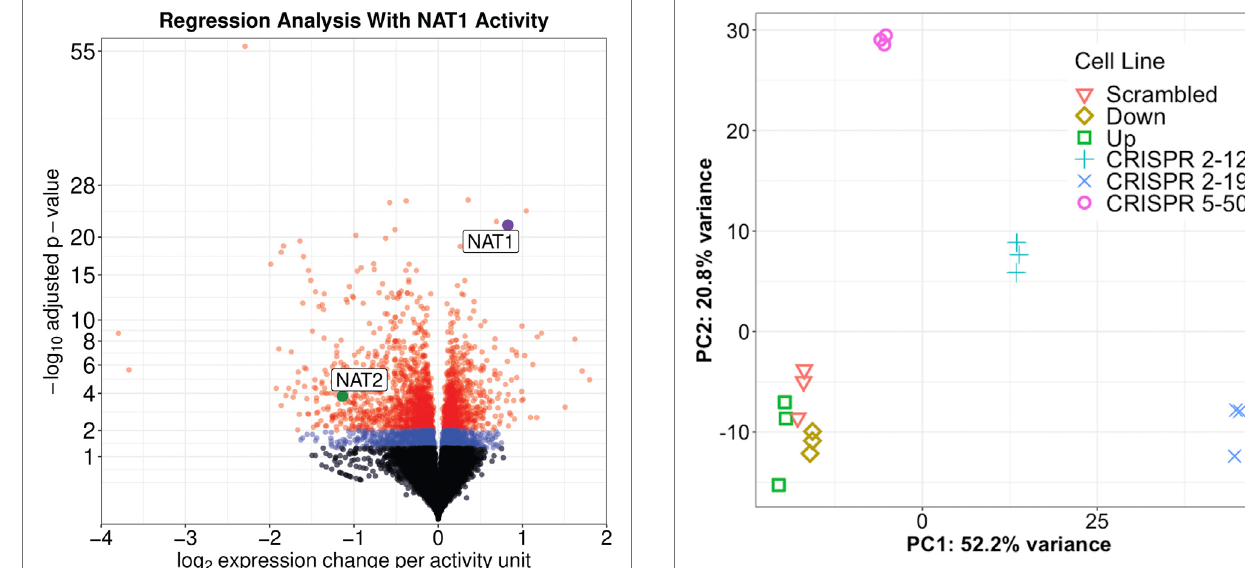
FIGURE 2 | Expression of Many Genes, including NAT1 and NAT2, are signi fi cantly associated with NAT1 Activity. Signi fi cance and effect size are visualized for all genes inthe dataset.Genes with anadjustedsigni fi cance value greater than 0.05 are shown by black dots, genes with an adjusted signi fi cance value between 0.05 and 0.01 are shown by blue dots, and genes withanadjustedsigni fi cance value lessthan0.01are shown byred dots. NAT1 is shown by a purple dot and NAT2 is shown by a green dot; both are